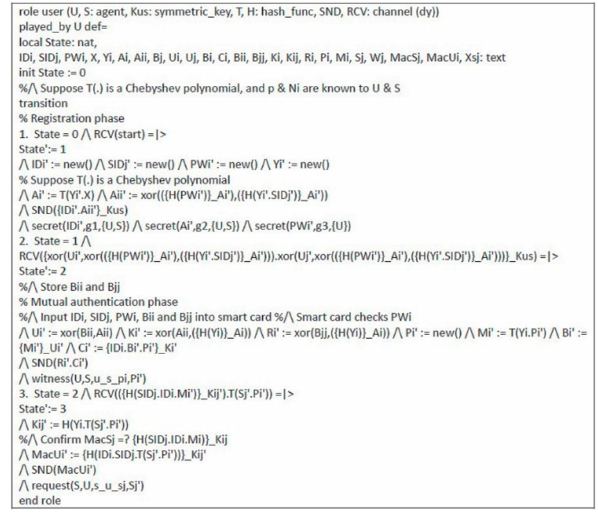
Figure 6. HLPSL specification of user.